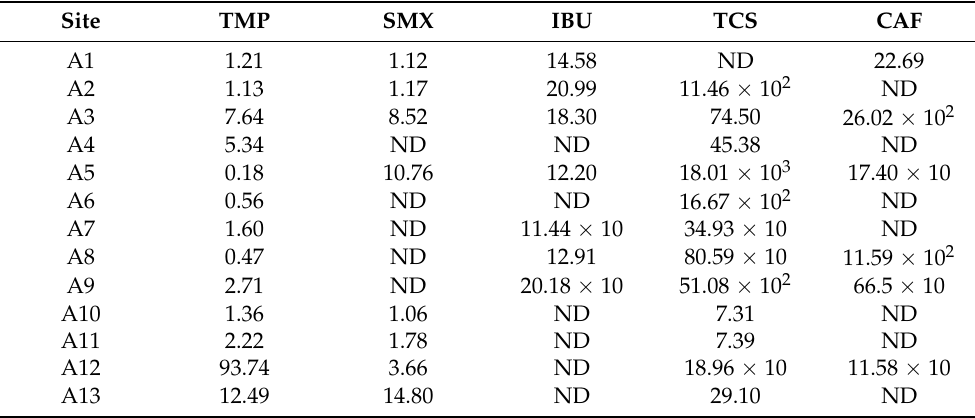
Table 2. Pseudo-partitioning of 5 PPCPs in the North Canal.